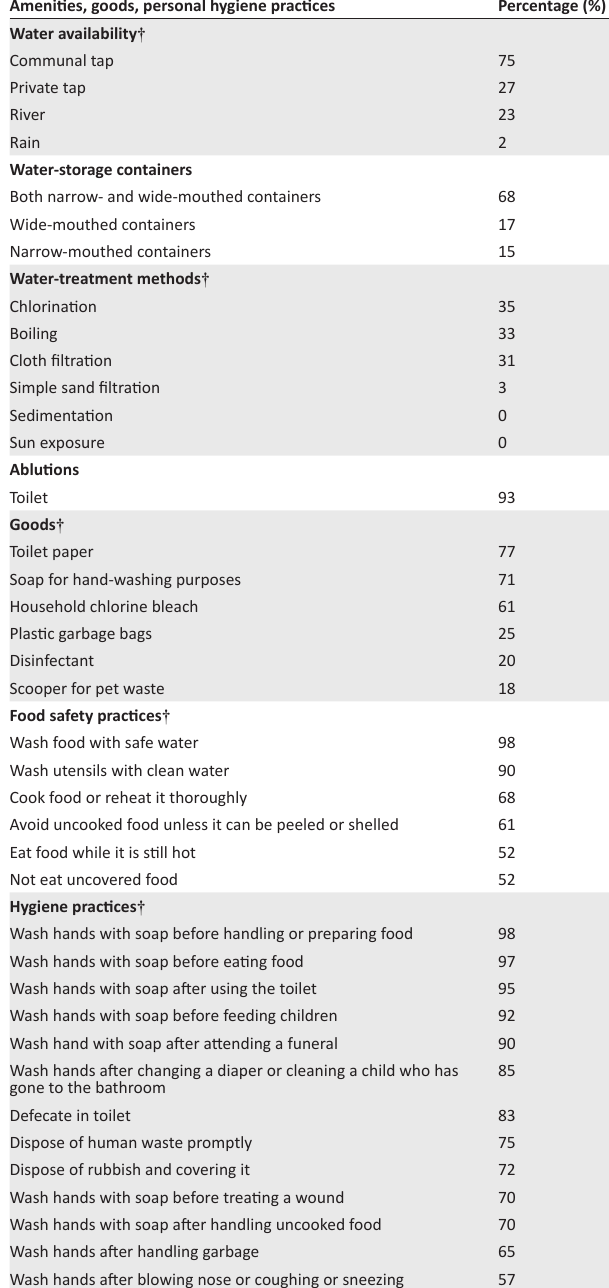
TABLE 6: The availability of amenities and goods and personal hygiene practices of respondents. Amenities, goods, personal hygiene